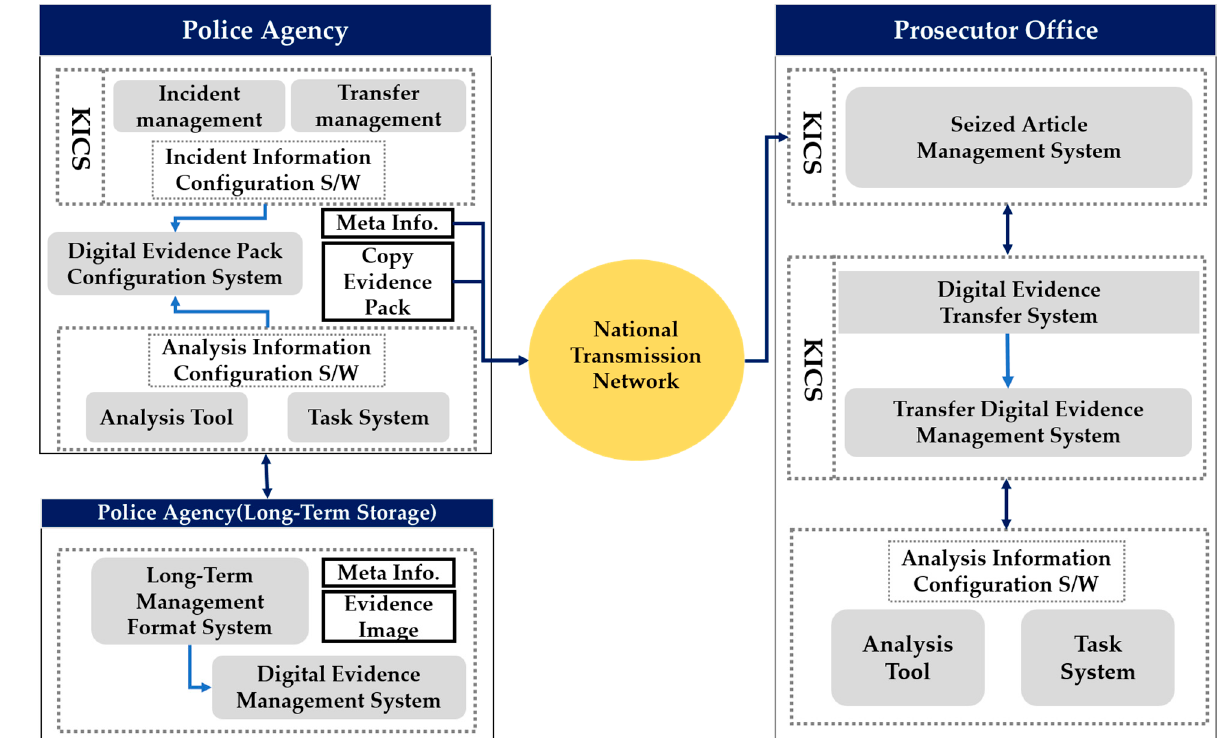
Figure 1. System structure of the existing integrated digital evidence management system.